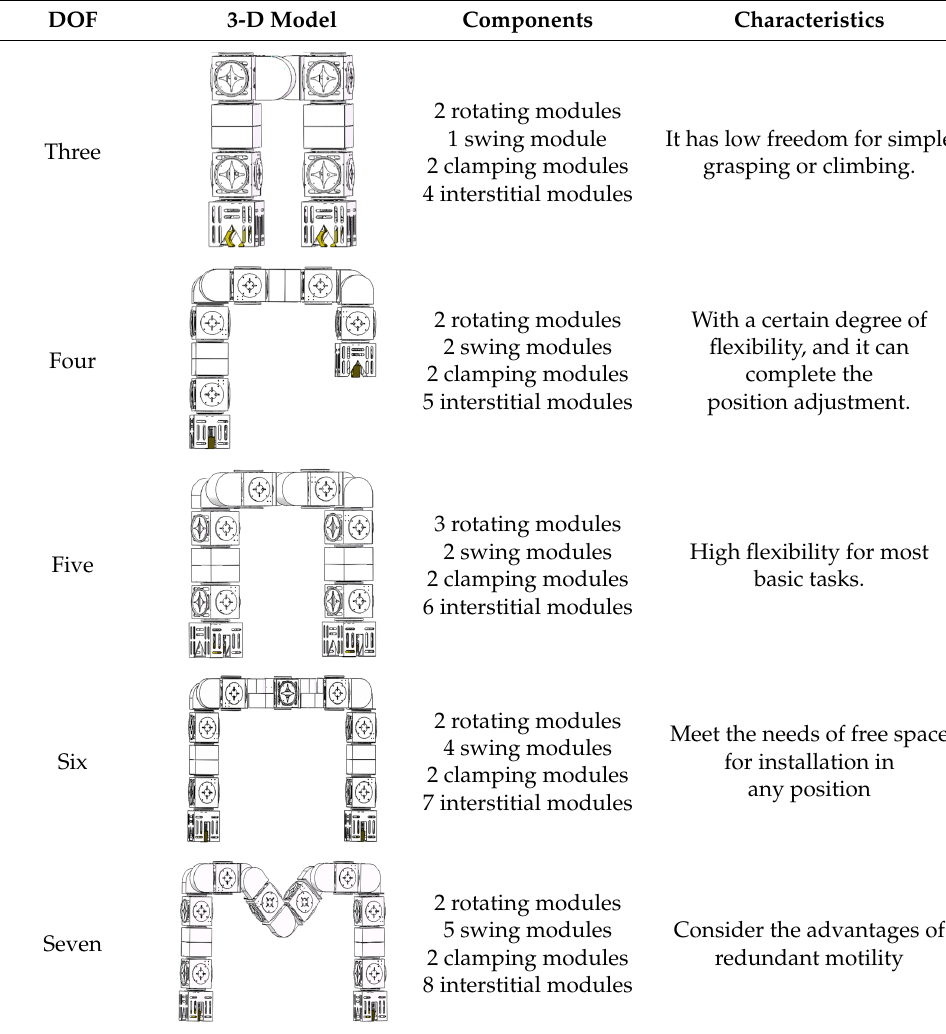
Figure 1. Module composition of the self-reconfiguring robot. Table 1. Self-reconfiguring robot configuration design scheme.